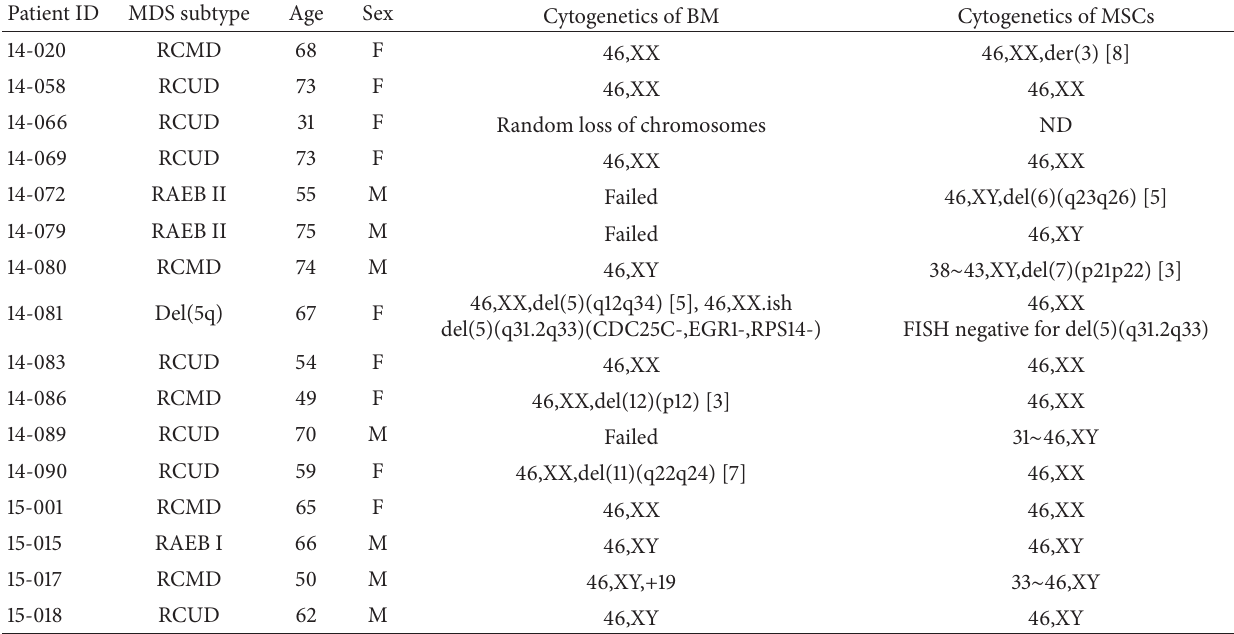
Table 1: Cytogenetic findings of bone marrow and MSCs of MDS